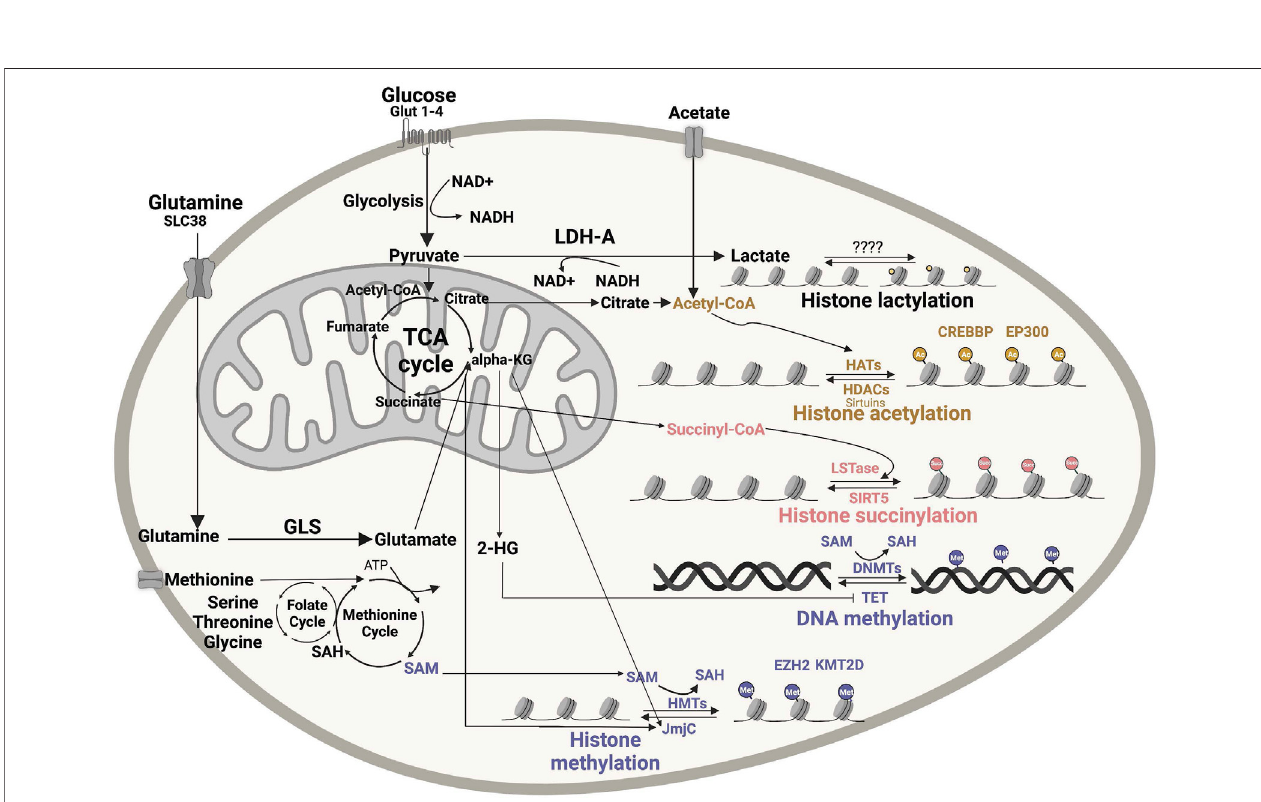
FIGURE 1 | Impact of metabolic intermediates on cellular epigenomic. Numerous nutrients are metabolized to produce intermediates that can be used as substrates or modulators of enzymes involved in chromatin remodeling. Acetyl-CoA, lactate, succinyl-CoA and SAM are the major metabolic bioproducts involved in epigenetic reactions, including histone acetylation, histone methylation, succinylation, lactylation and DNA methylation. DNMT, DNA methyltransferases; GLS, glutaminase; 2-HG, 2-hydroxyglutarate; a-KG, α -ketoglutarate; SAH, S-adenosyl homocysteine; SAM, S-adenosyl methionine dehydrogenase 1; HAT, histone acetyltransferase; HDAC, histone deacetylases; HMT, histone methyltransferase; JmjC, Jumonji N/C-terminal domains; LDH-A, lactate dehydrogenase A; LSTase, lysine succinyltransferase; NAM, nicotinamide; SIRT, sirtuin; TCA, tricarboxylic acid; EZH2- Enhancer Of Zeste 2 Polycomb Repressive Complex 2 Subunit, KMT2D- Histone-lysine N-methyltransferase 2D. Figures were created using BioRender.com.